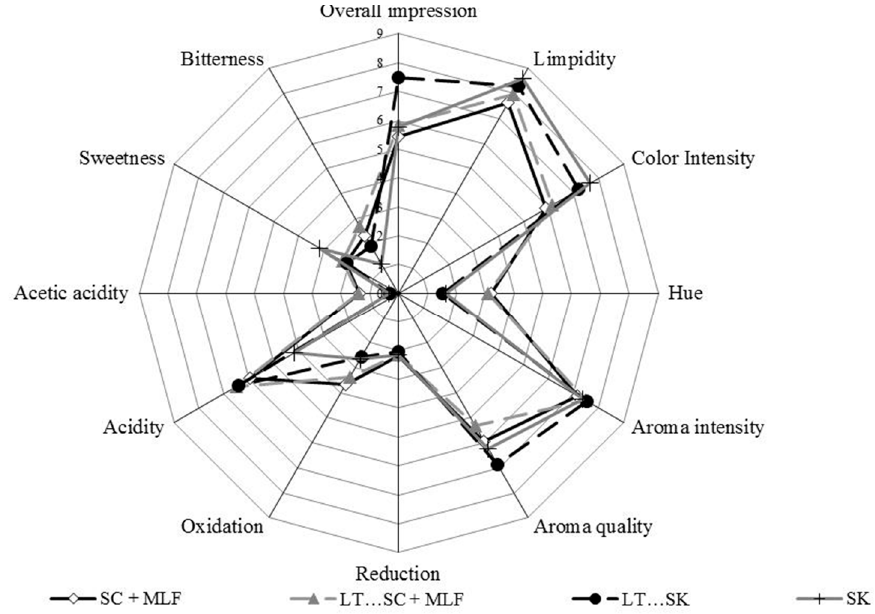
Figure 3. Results of the sensory analysis of bottled wines from different fermentation processes of Saccharomyces cerevisiae 88 alone (SC), sequential fermentation with Saccharomyces cerevisiae 88 and L. thermotolerans CONCERTO™ (LT . . . SC), sequential fermentation with S. pombe V2 and L. thermotolerans CONCERTO™ (LT . . . SK), S. pombe V2 alone (SK), and fermentations after malolactic fermentation with Oenococcus oeni 217 (+ MLF).